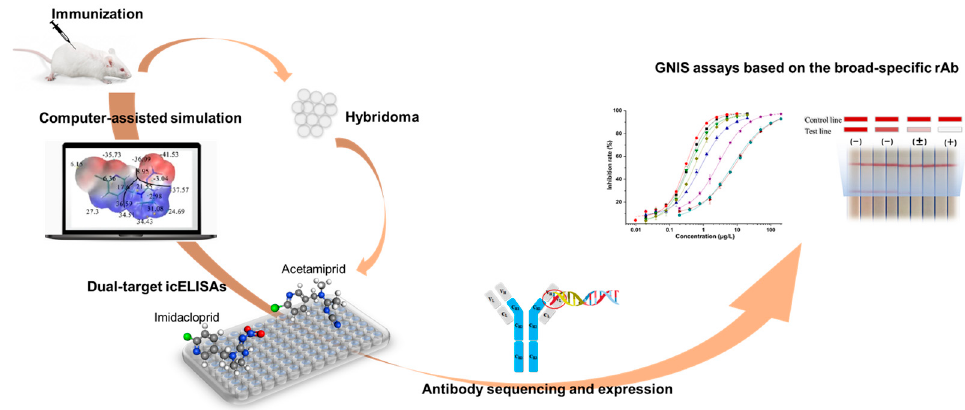
Figure 1. Scheme of the development of a novel broad-specific antibody and the immunosensing strip for 8 neonicotinoids.